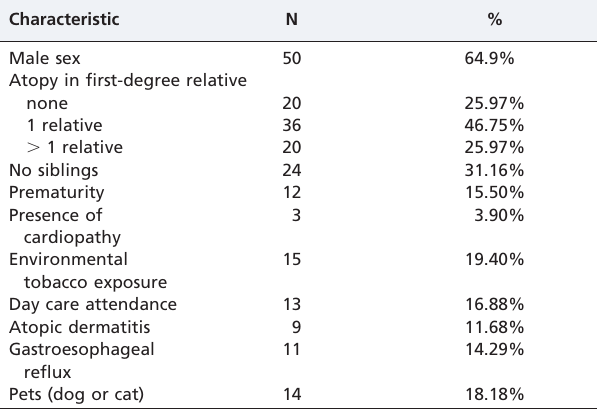
Table 1 - Demographic data of the 77 infants with bronchiolitis included in the study at the Hospital Israelita and July